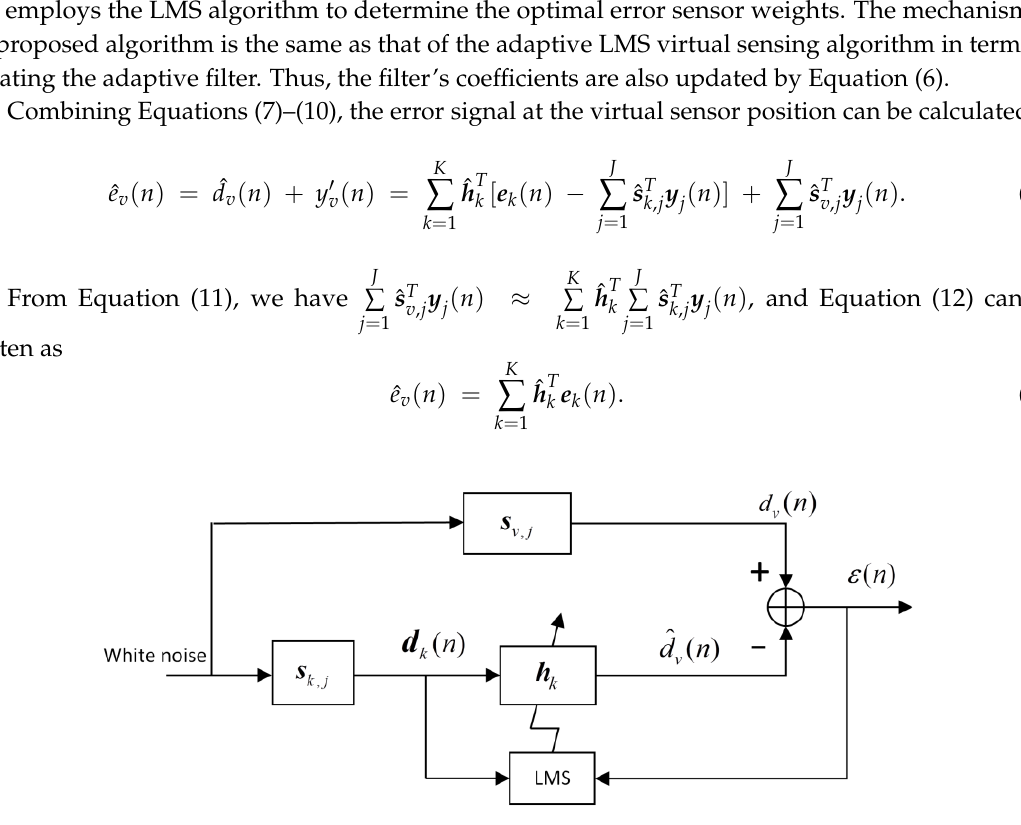
Figure 5. Block diagram of the modified adaptive LMS algorithm to calculate microphone weights.